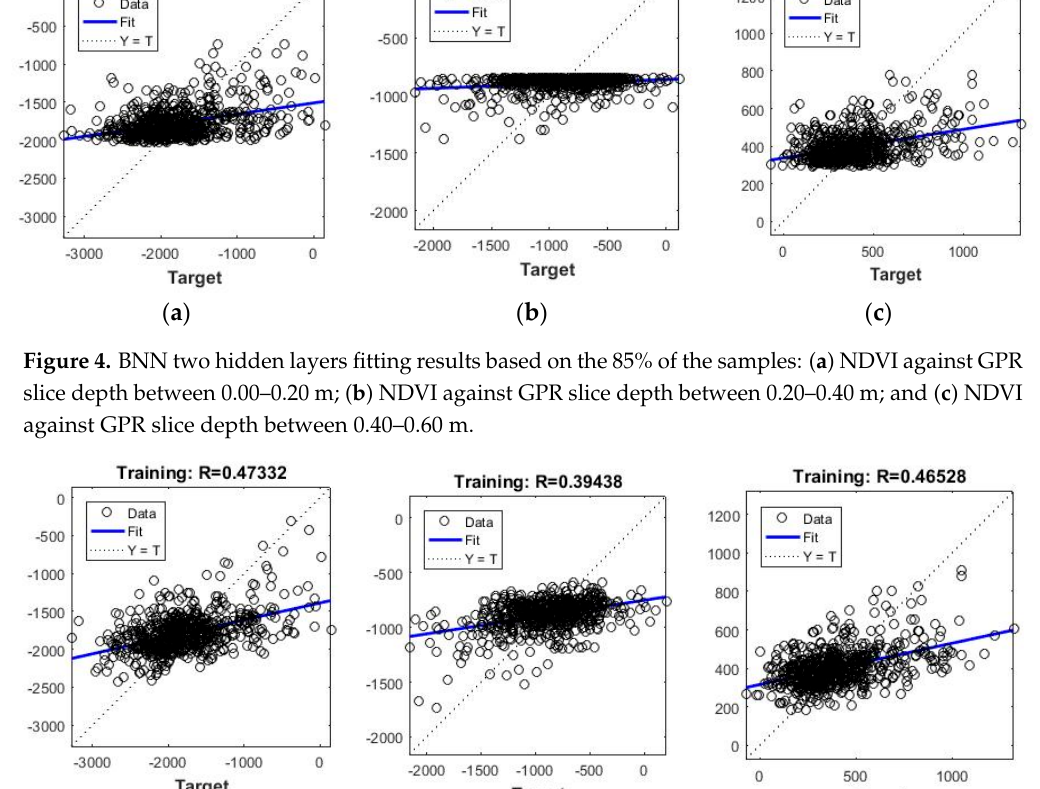
( b ) ( c ) Figure 6. BNN two hidden layers fitting results based on the 85% of the samples: ( a ) Group of multispectral vegetation indices against GPR slice depth between 0.00–0.20 m; ( b ) Group of multispectral vegetation indices against GPR slice depth between 0.20–0.40 m; and ( c ) Group of multispectral vegetation indices against GPR slice depth between 0.40–0.60 m. In contrast, when the third cluster was used as input in the fusion model (i.e., hyperspectral vegetation indices), it was observed a major increased of the regression value; 0.67, 0.64, and 0.64 for the depth slices 0.00–0.20 m, 0.20–0.40 m, and 0.40–0.60 m below ground surface respectively (see Figure 7). Thus, hyperspectral indices provided more accurate fusion models between the ground spectral signatures and the GPR results. On the other hand, analysis based on the use of the whole dataset did not significantly improve these results as shown in Figure 8.